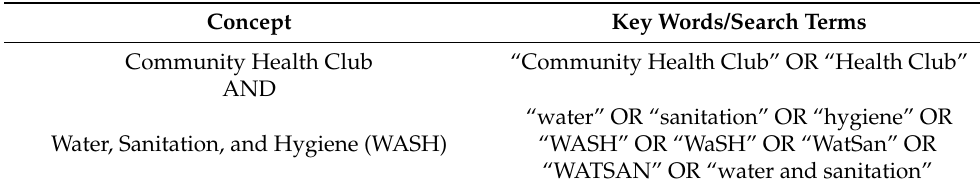
Table 1. Community health club (CHC) literature review search